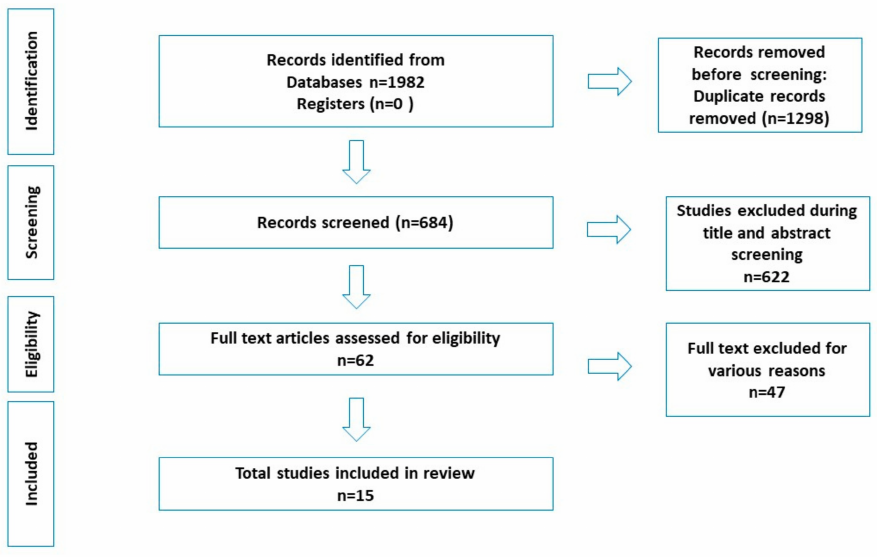
Figure 1. PRISMA